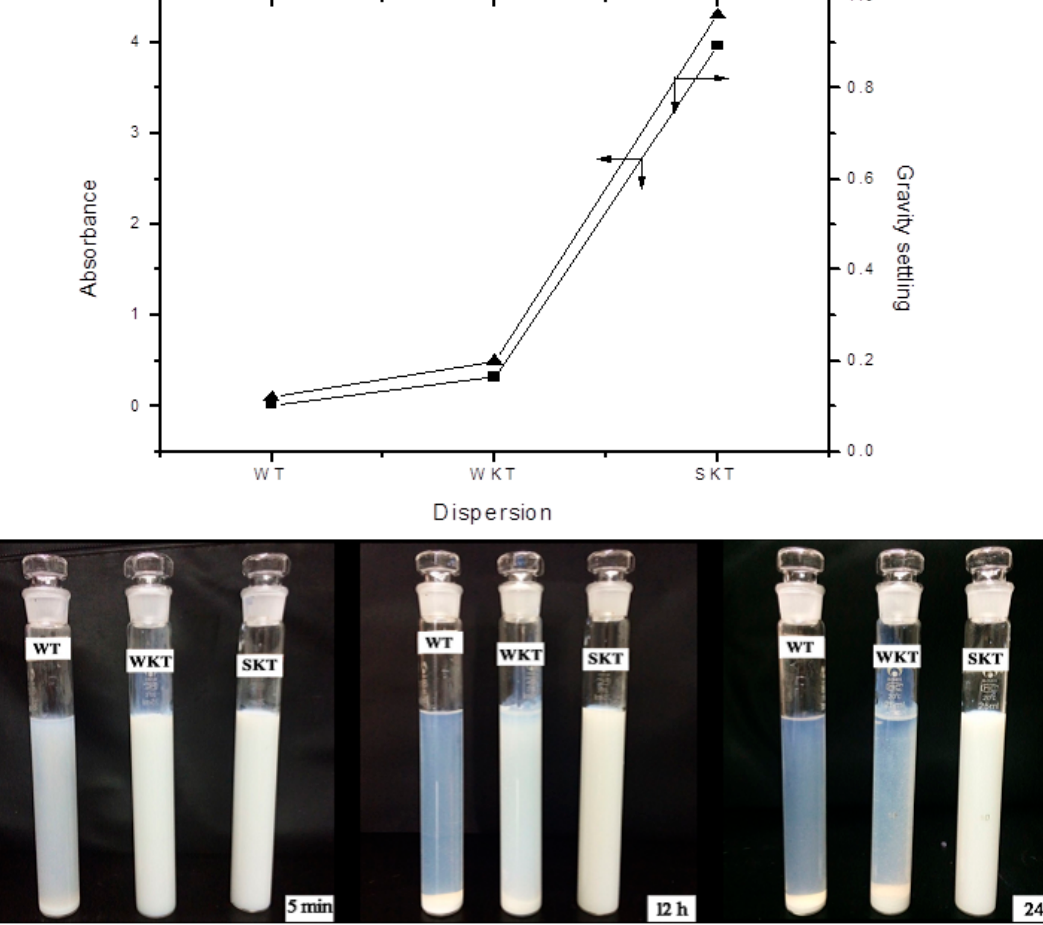
Figure 4. The absorbance and gravity distribution index of TiO 2 -KH550 dispersion (WT refers to the dispersion of nano-TiO 2 in deionized water, and WKT refers to the dispersion of TiO 2 -KH550 in deionized water; SKT, the dispersion of TiO 2 -KH550 in 0.04% SHMP).